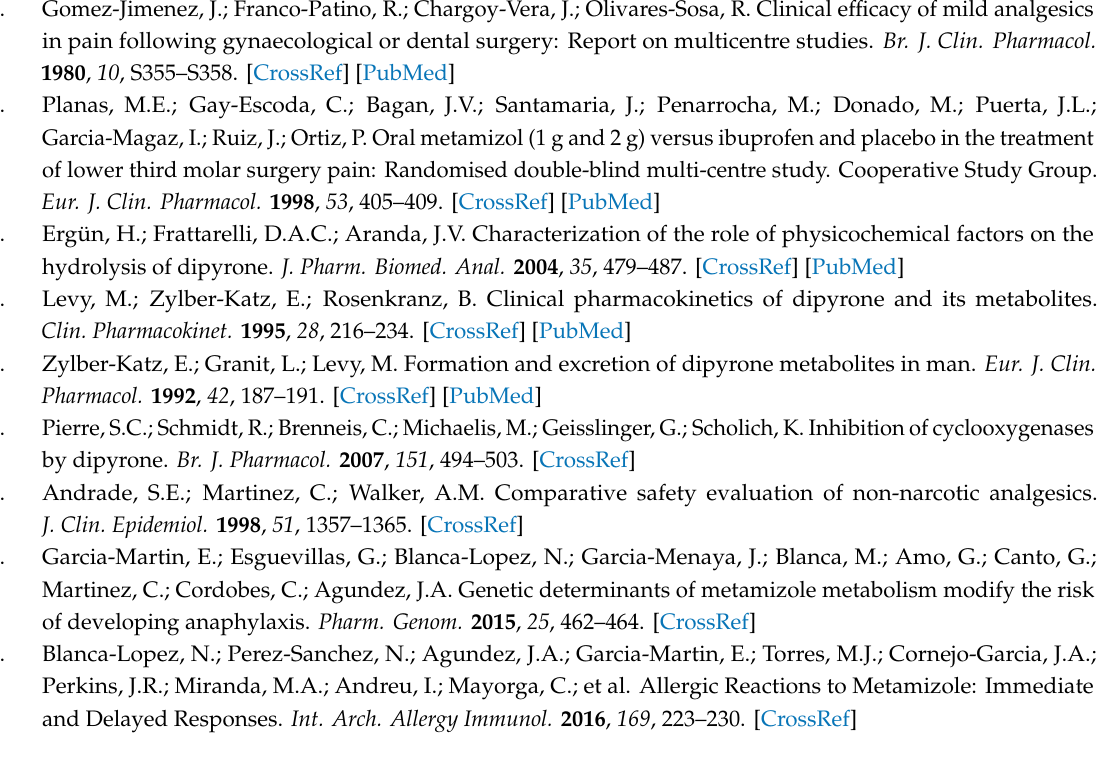
Figure S1: Quantification of the results shown in Figure 2. Figure S2: Mitochondrial DNA copy number. Figure S3: E ff ect MAA and / or hemin on mitochondrial membrane potential. Figure S4: Absolute cellular ATP content of the results shown in Figure